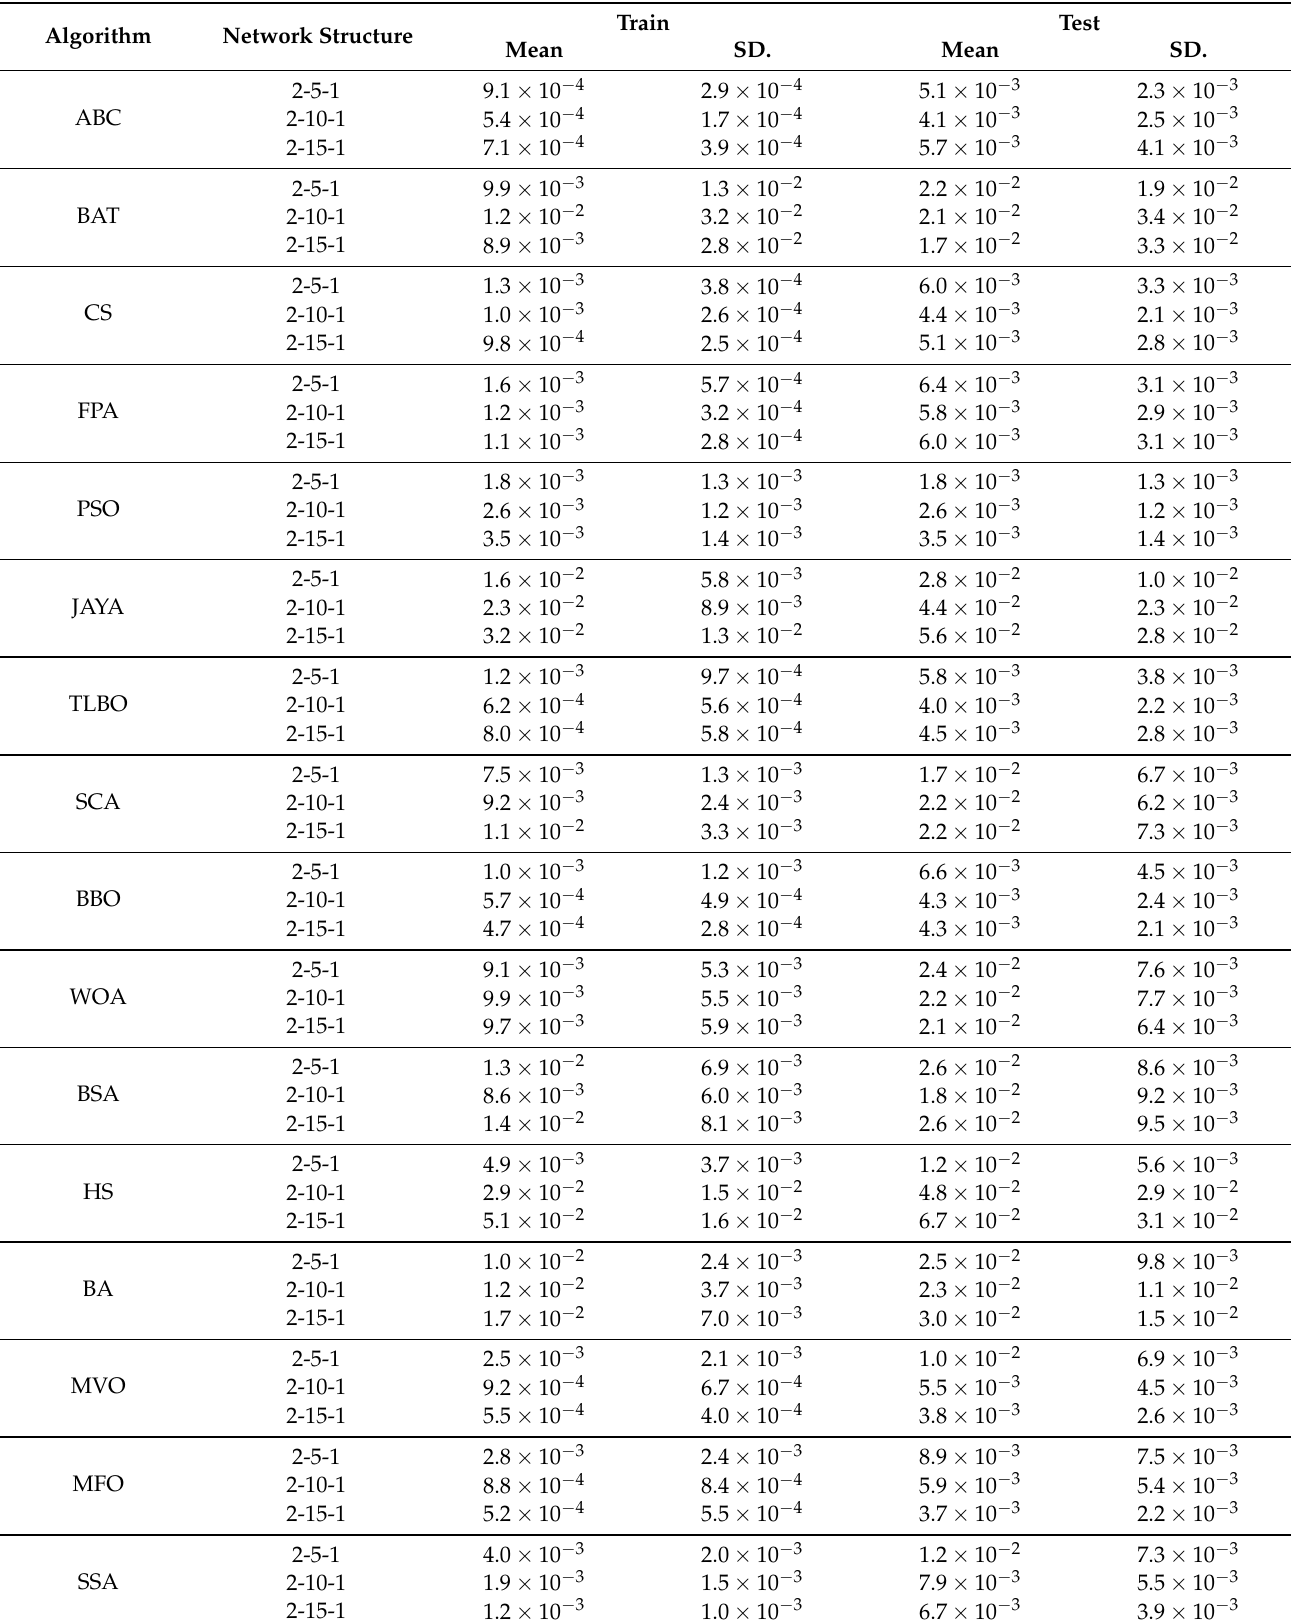
Table 3. The results obtained by using the metaheuristic algorithms for S 2